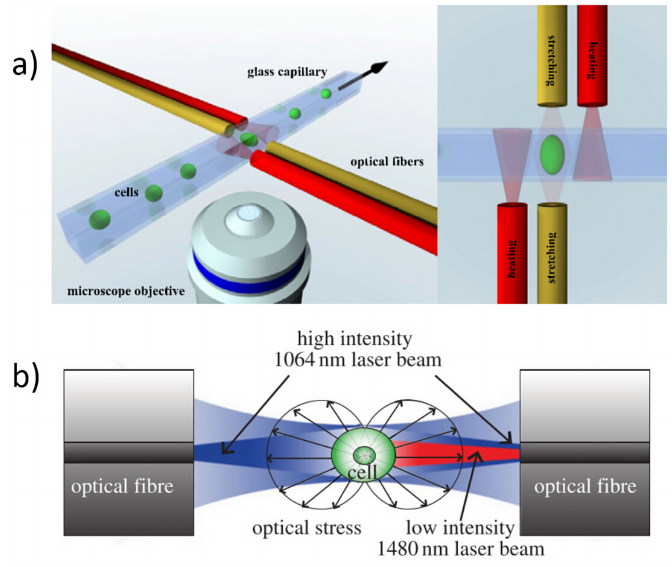
Figure 22. Active temperature control for optical stretcher. ( a ) Two additional fibers are added and positioned near the two opposing stretching fibers for temperature control; ( b ) Another laser is coupled into one of the two stretching fibers for temperature control. Figure reproduced from Reference [76,79] under CC-BY 3.0 license.